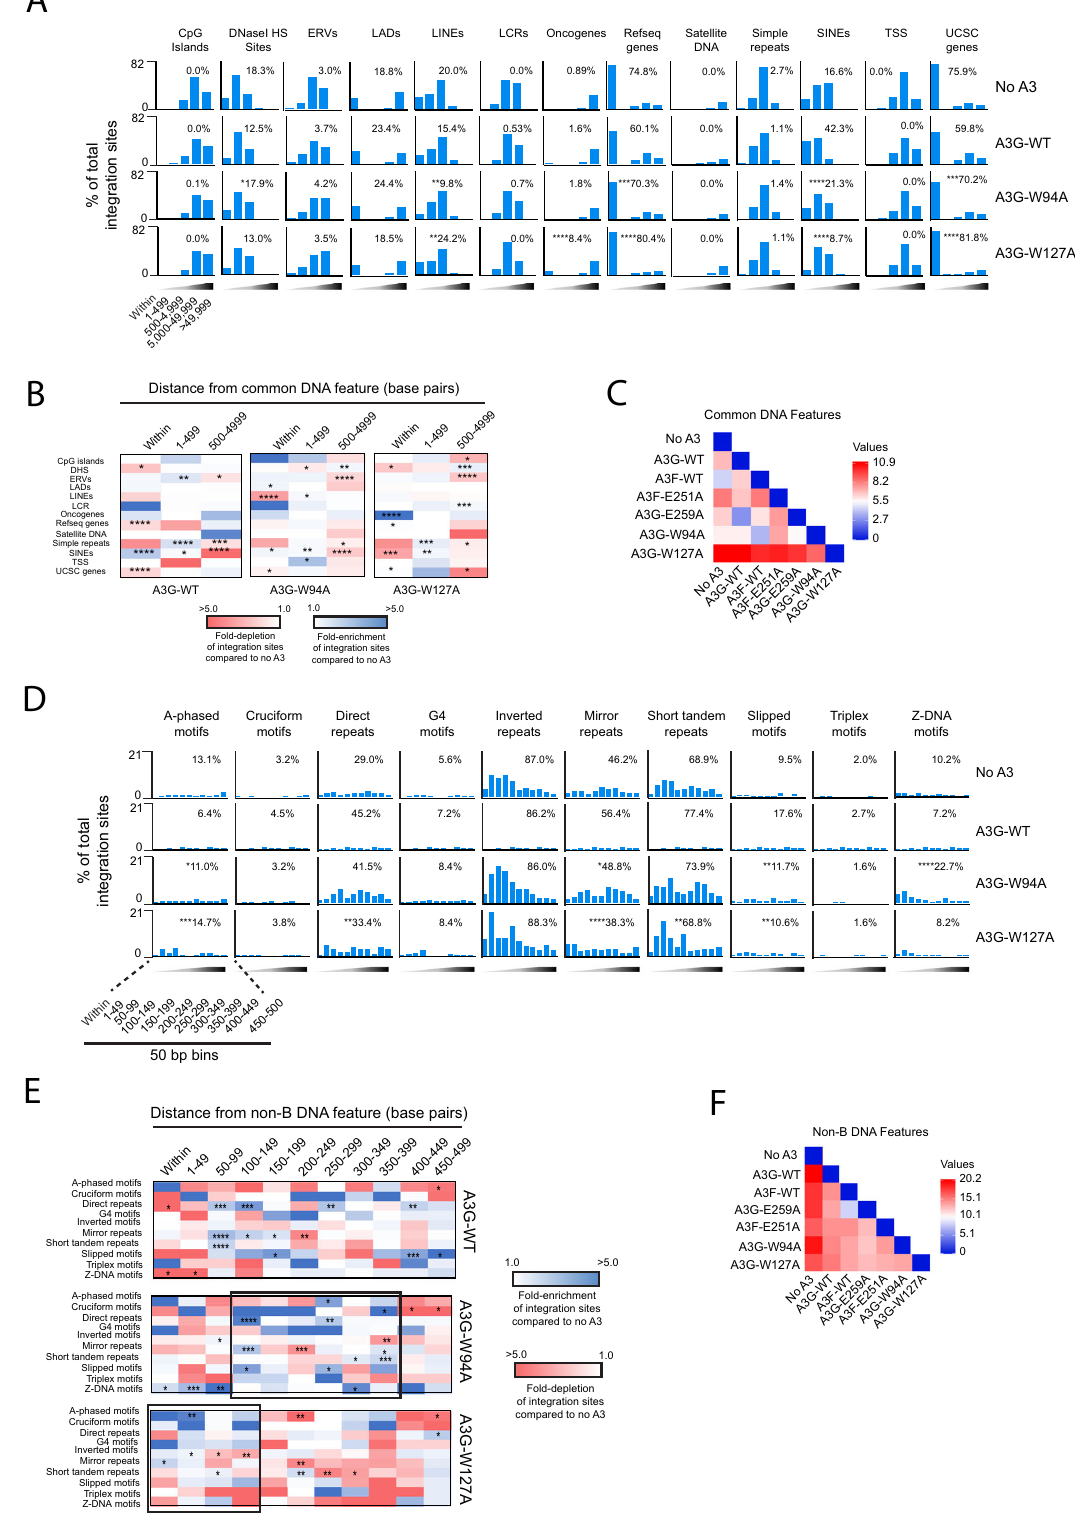
A3F-LTR-GA, A3G-LTR-AG exhibited a striking change in integration sitepro fi lewithrespecttonon-BDNA.Integrationwasenrichedinand/ or near most non-B DNA features. Together, these data show that A3- induced G-to-A mutations at position 14 or 15 from the end of the 3 ’ LTR correlates with a signi fi cantly altered integration site pro fi le with enrichment near transcription-silencing non-B DNA